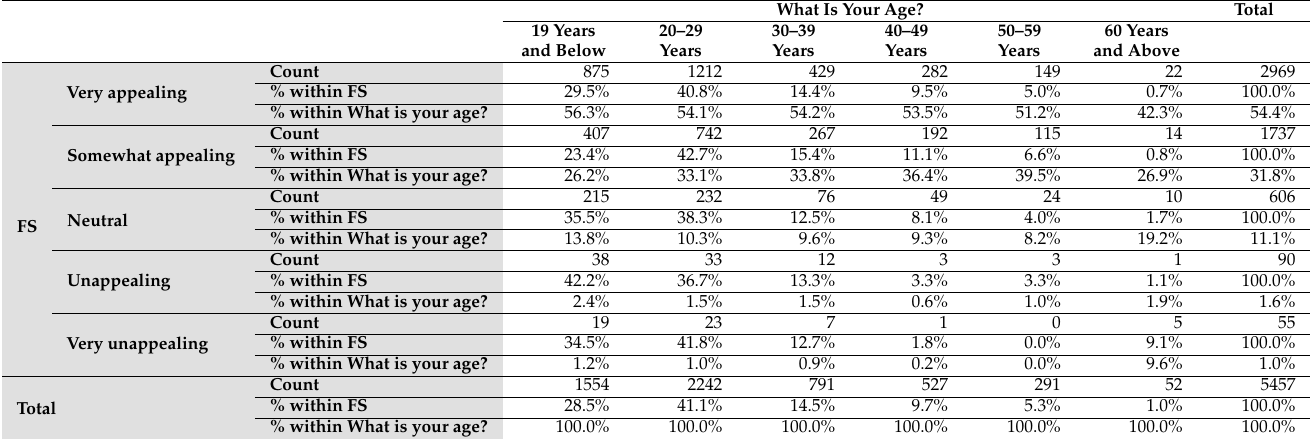
Table 16. Functional societal value of EVs and respondents’ age